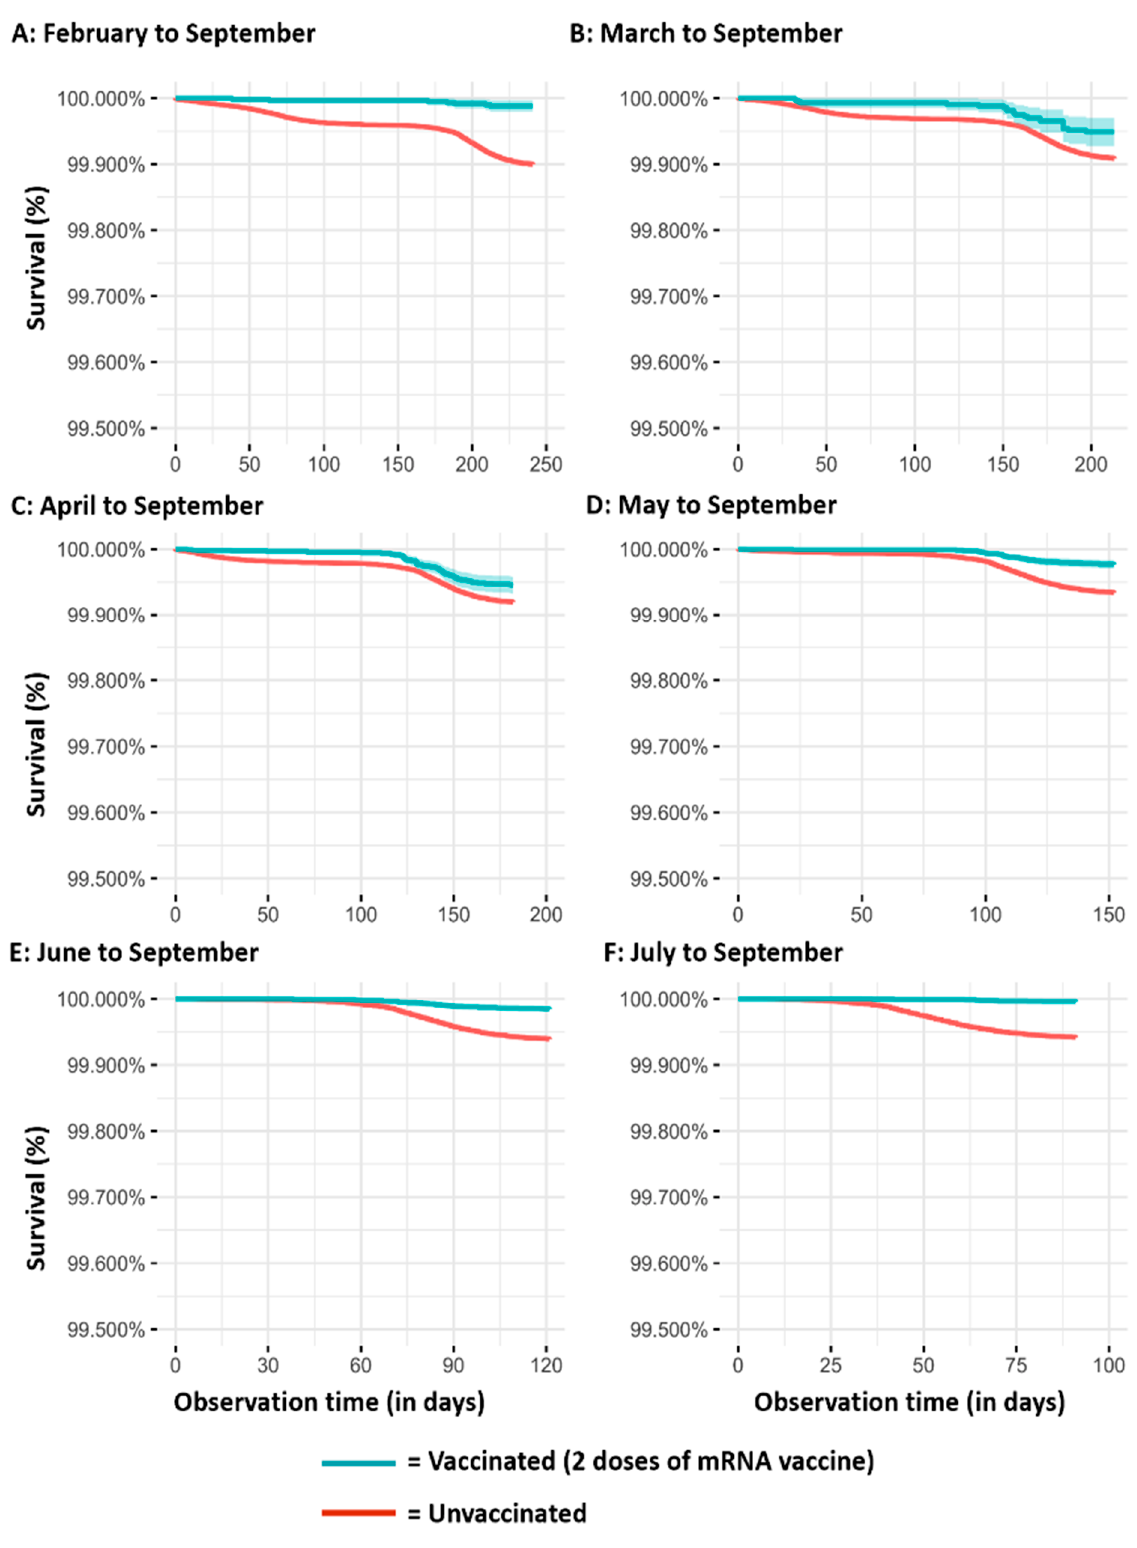
Figure 3. Kaplan–Meier survival analyses on COVID-19 intubation or death over time in vaccinated and unvaccinated subjects according to the different observation periods (( A ): February to September; ( B ) March to September; ( C ) April to September; ( D ) Mayto September; ( E ) June to September; ( F ): July to September).